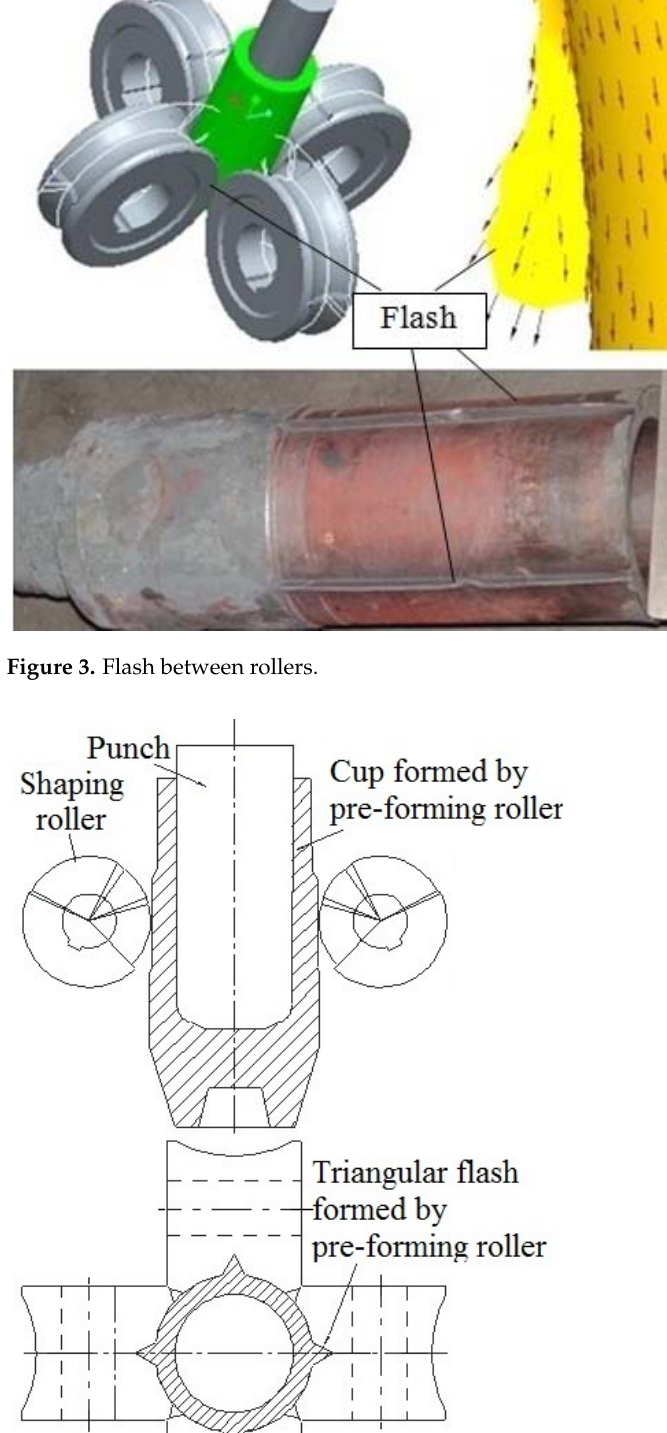
Figure 2. Schematic diagram of roll forming.